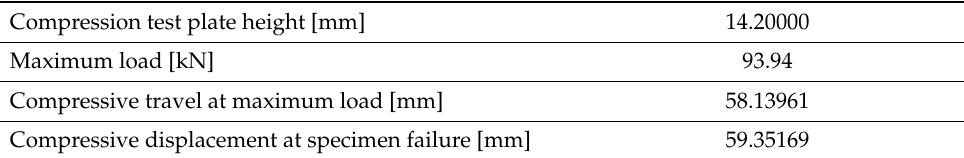
Figure 14. Graph of the sample destruction. (cid:78) —Compressive displacement at specimen failure. • —Compressive travel at maximum load. Table 16. The experiment